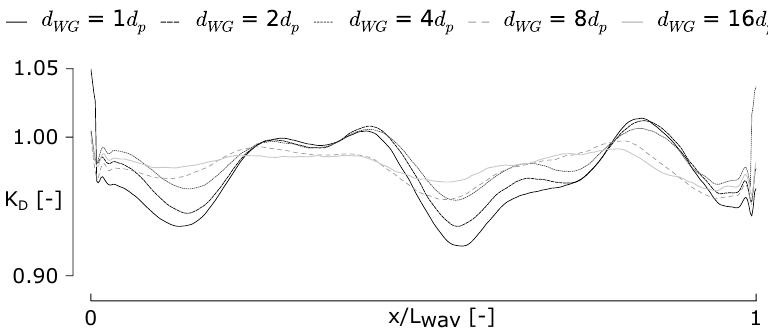
Figure 4. Sensitivity analysis on distance d WG from the wave measurement locations WG in and WG out to the inlet/outlet buffer zone, necessary for accurate wave propagation, represented by the ratio K D along the fluid